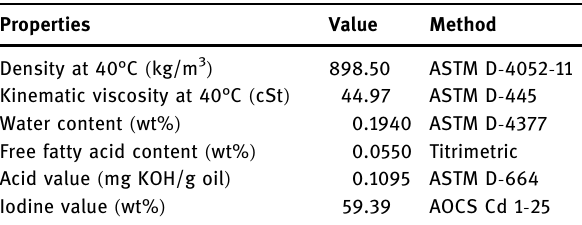
Table 2: Physical properties of palm oil [ 33 ]